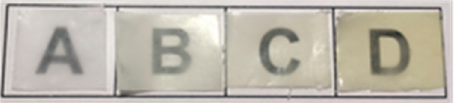
Figure 2. Contact transparency image of the plain poly( ε -caprolactone) PCL film (A) and the PCL-based films containing: 5% (B), 10% (C), and 20% (D) SE.